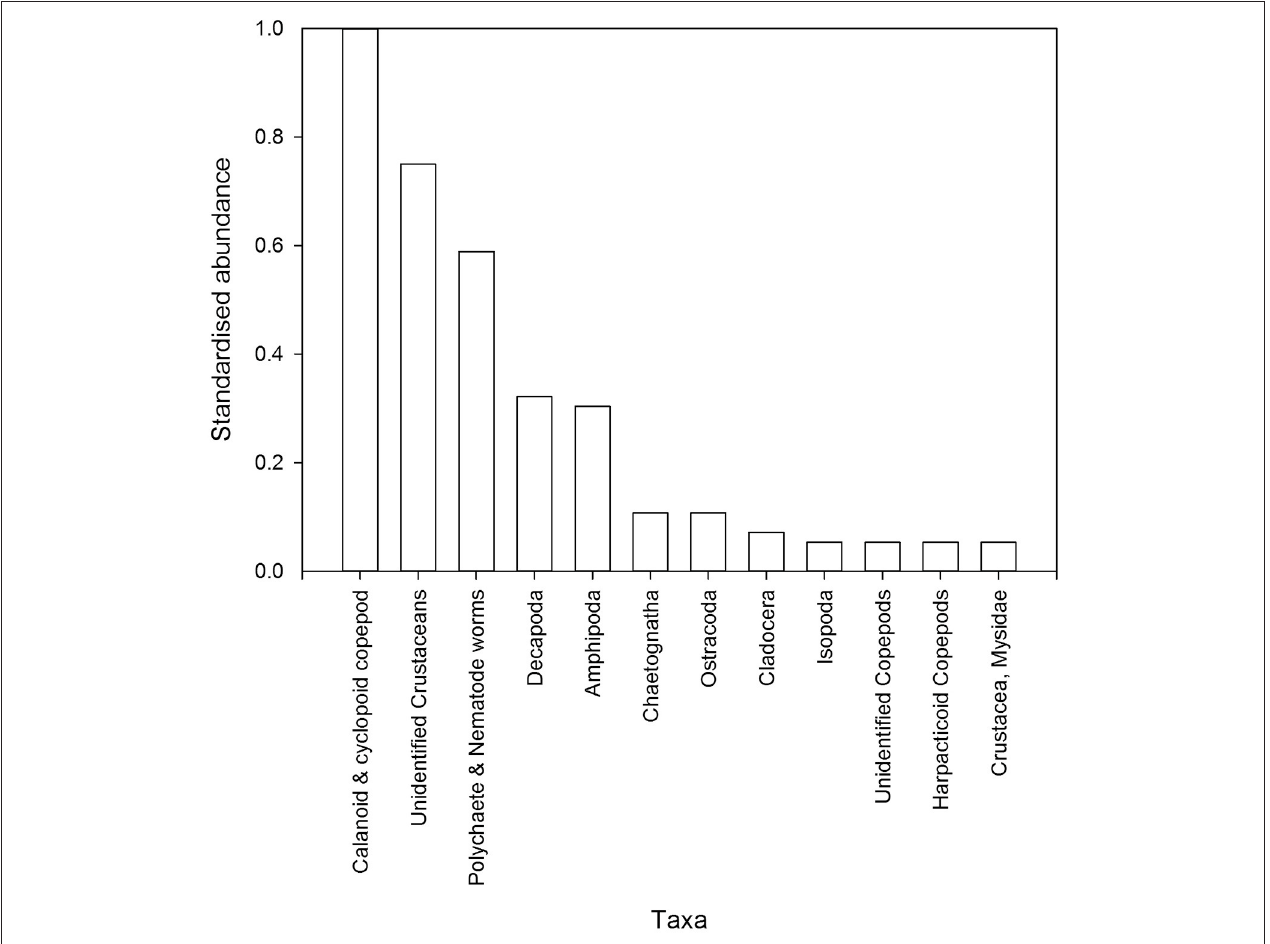
FIGURE 4 | Abundance of invertebrates from post-settlement snapper gut contents ( n = 35 individual fish) collected from all sites in 2015 and 2016. Abundances are standardized by the most abundant taxa and ordered from most to least abundant. Taxonomic nomenclature presented is not always at the same level, and in some cases has been pooled to likely snapper diet